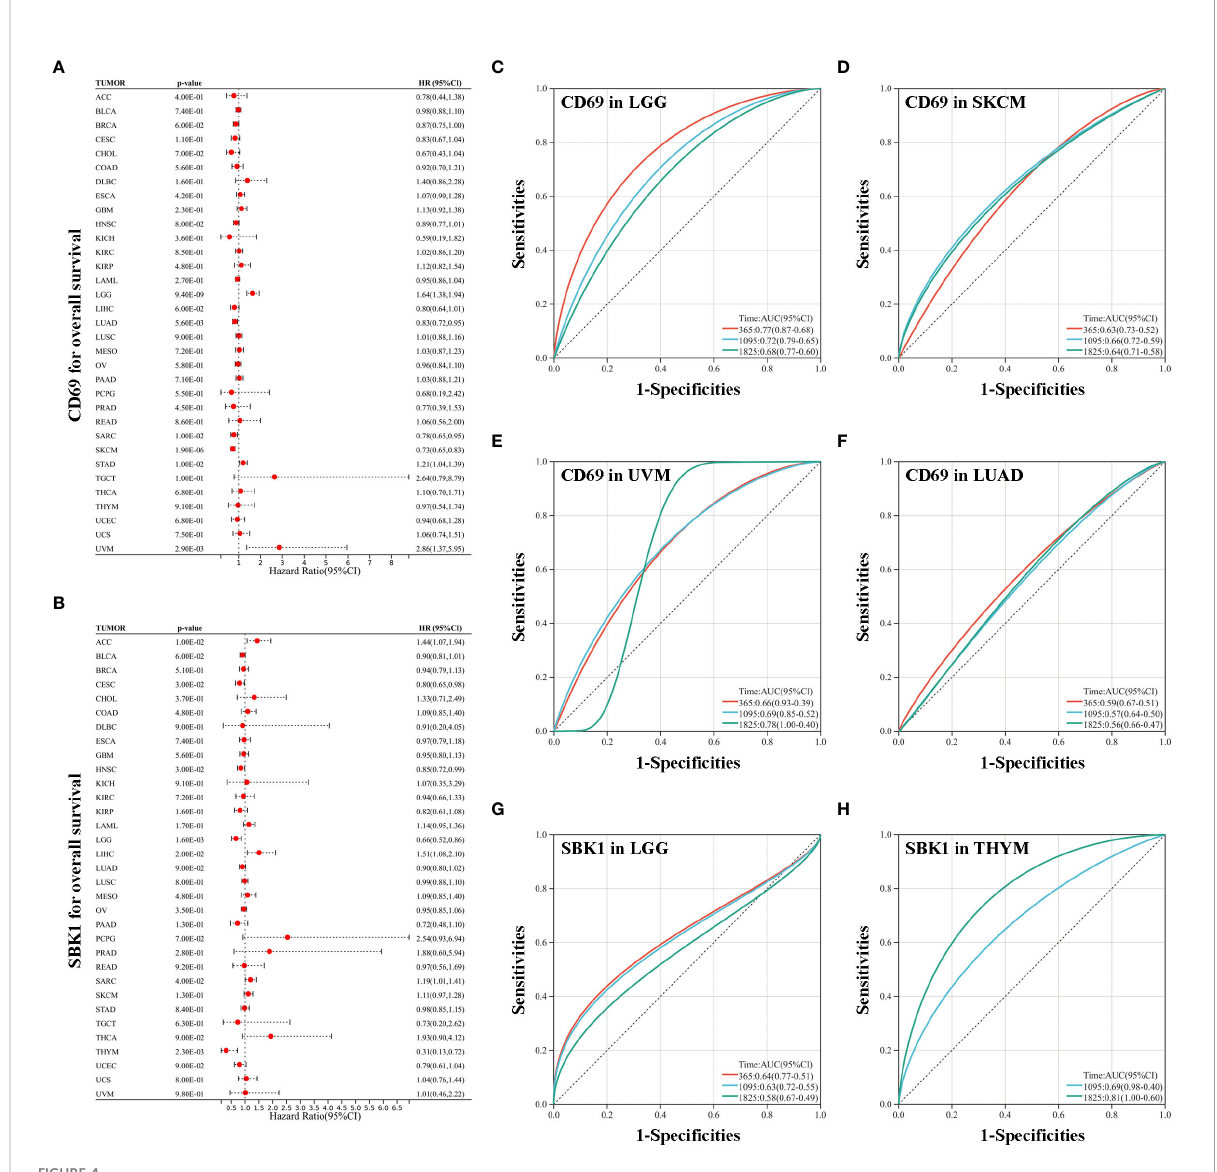
FIGURE 4 Analysis of the correlation between survival and the expression levels of CD69 and SBK1 . (A) CD69 expression levels correlate with poor prognosis in LGG, STAD and UVM, and with improved prognosis in LUAD, SARC and SKCM. (B) SBK1 expression levels correlate with poor prognosis in ACC, LIHC and SARC, and with improved prognosis in CESC, LGG and THYM. (C – F) ROC analysis of the ability of CD69 to predict the 1-, 3-, and 5-year OS of LGG (C) , SKCM (D) , UVM (E) , and LUAD (F) . (G, H) ROC analysis of the ability of SBK1 to predict the 1-, 3-, and 5- year OS of LGG (G) and THYM (H)